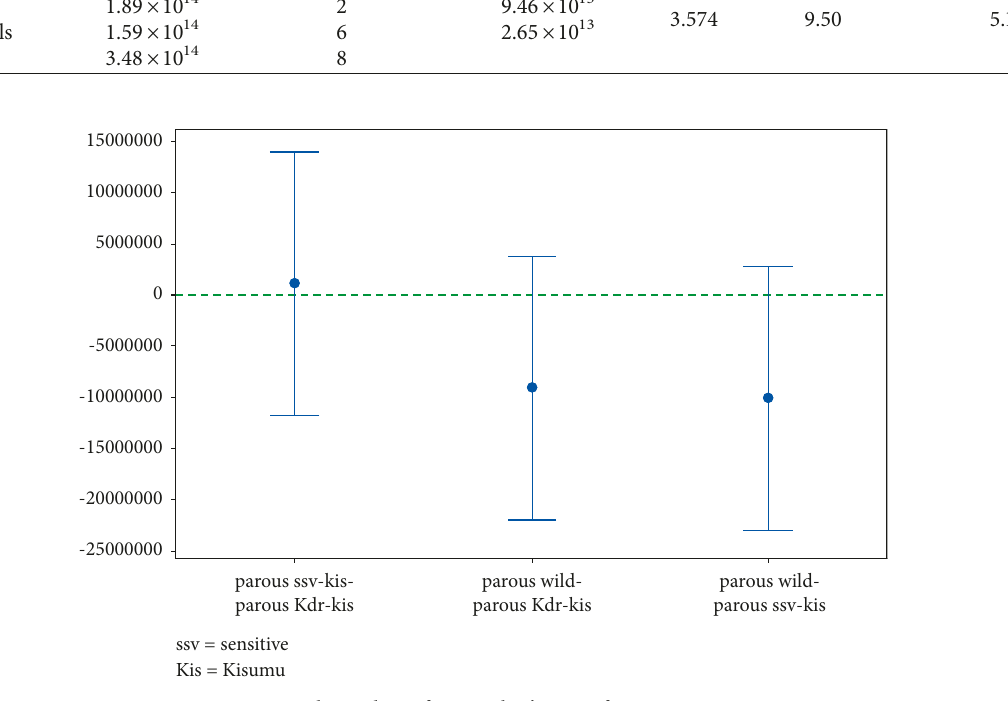
Figure 2: Graph resulting from Fisher’s test of parous mosquitoes. Table 2: Results of the analysis of the variance test of the different pools of Anopheles gambiae in the nongorged category. Source of variations Sum of squares Degree of freedom Average of squares F Probability Critical value for F Between pools 4.06 10 +15 ×